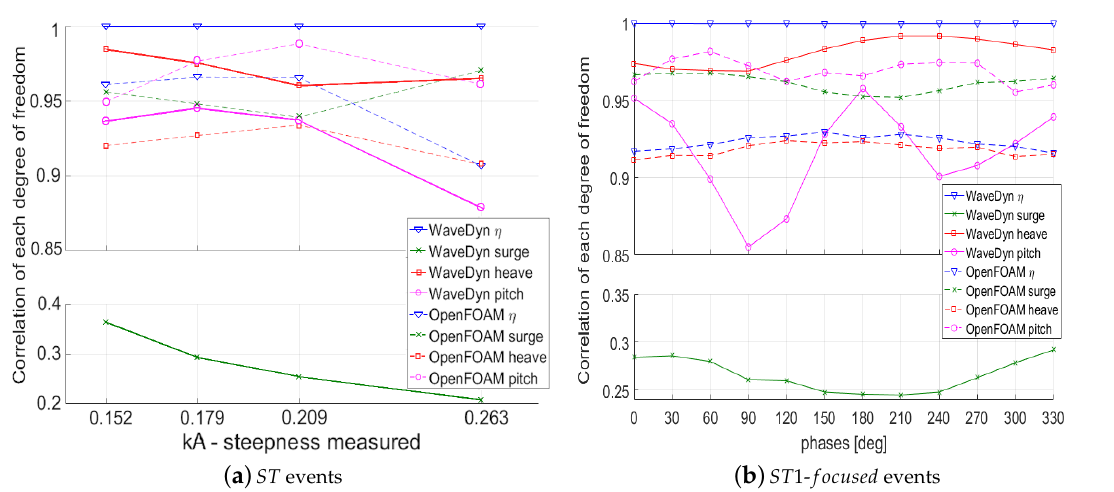
Figure 8. Correlation ( R ) between each numerical model and